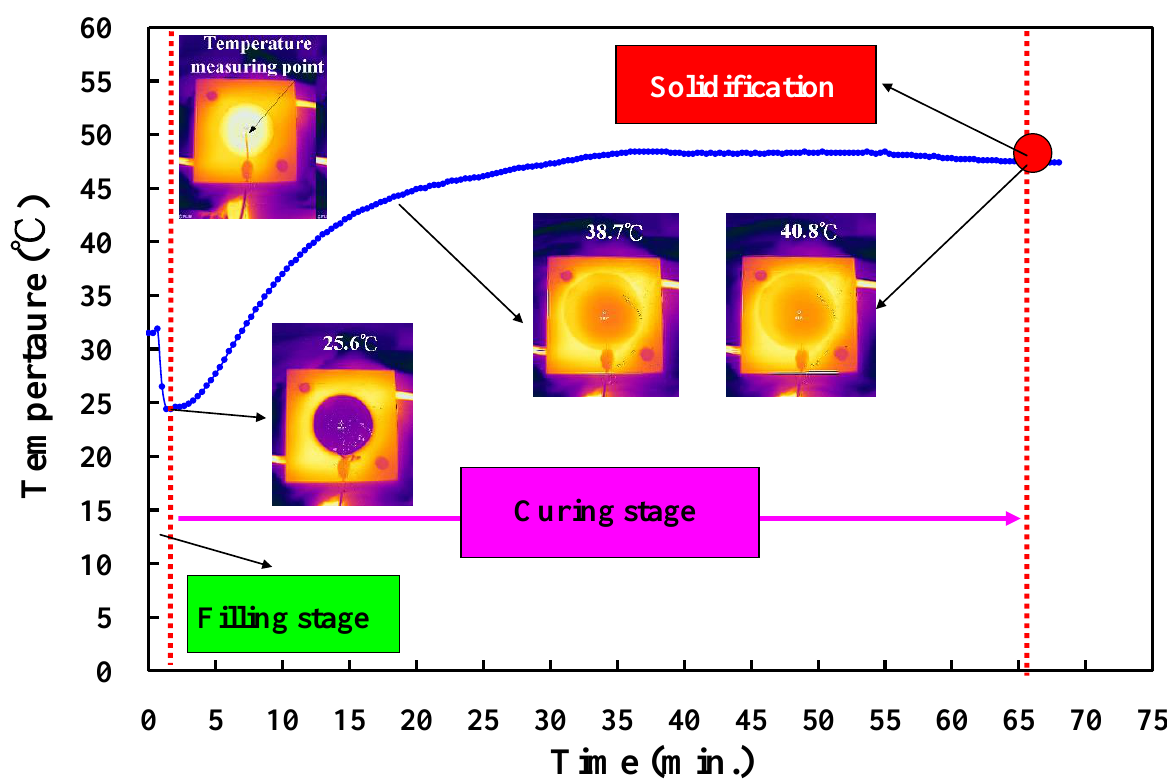
Figure 9. Temperature of a convex lens as a function of vulcanization time.